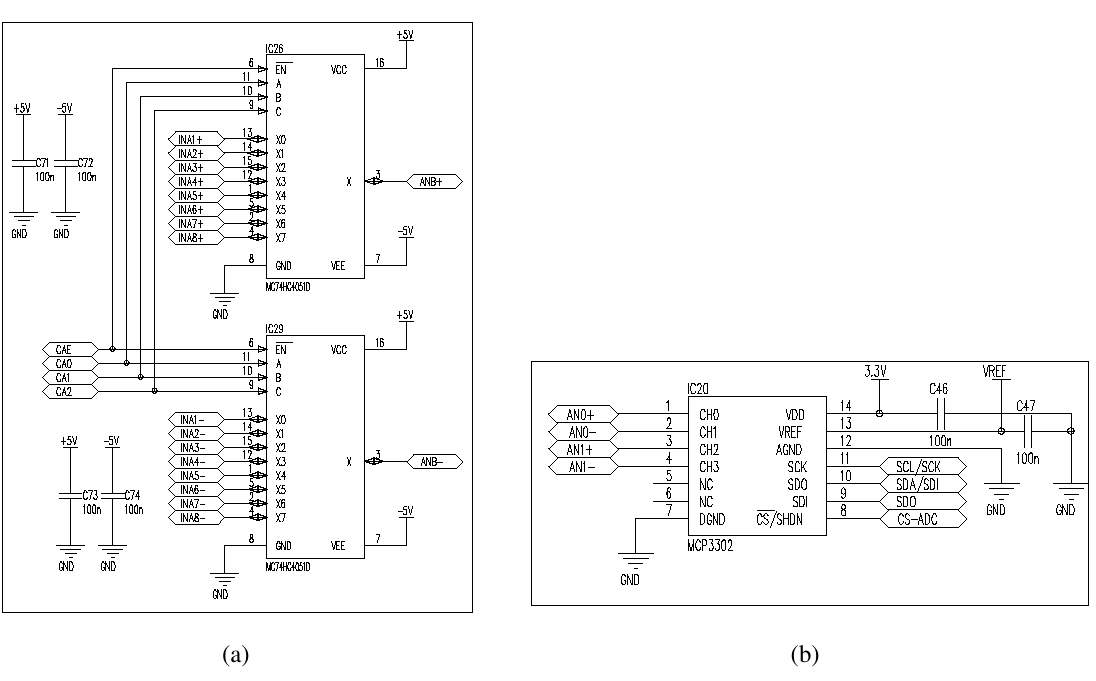
Figure 4. Circuit schematic of analog interfaces. ( a ) Selector of analog connections to plugged-in sensors, ( b ) ADC converter from output voltage to digital